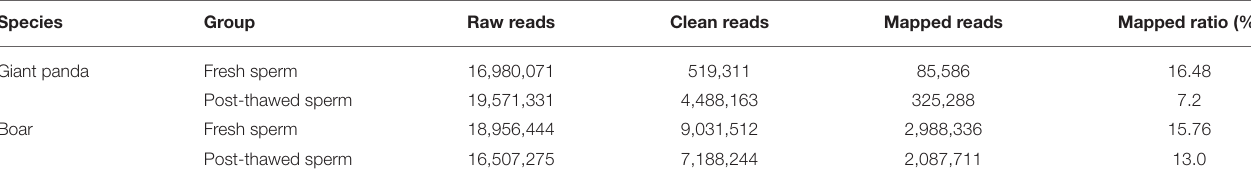
TABLE 1 | Overview of piRNA sequencing of fresh and frozen-thawed sperm in giant panda and boar. Species Group Raw reads Clean reads Mapped reads Mapped ratio (%) Giant panda Fresh